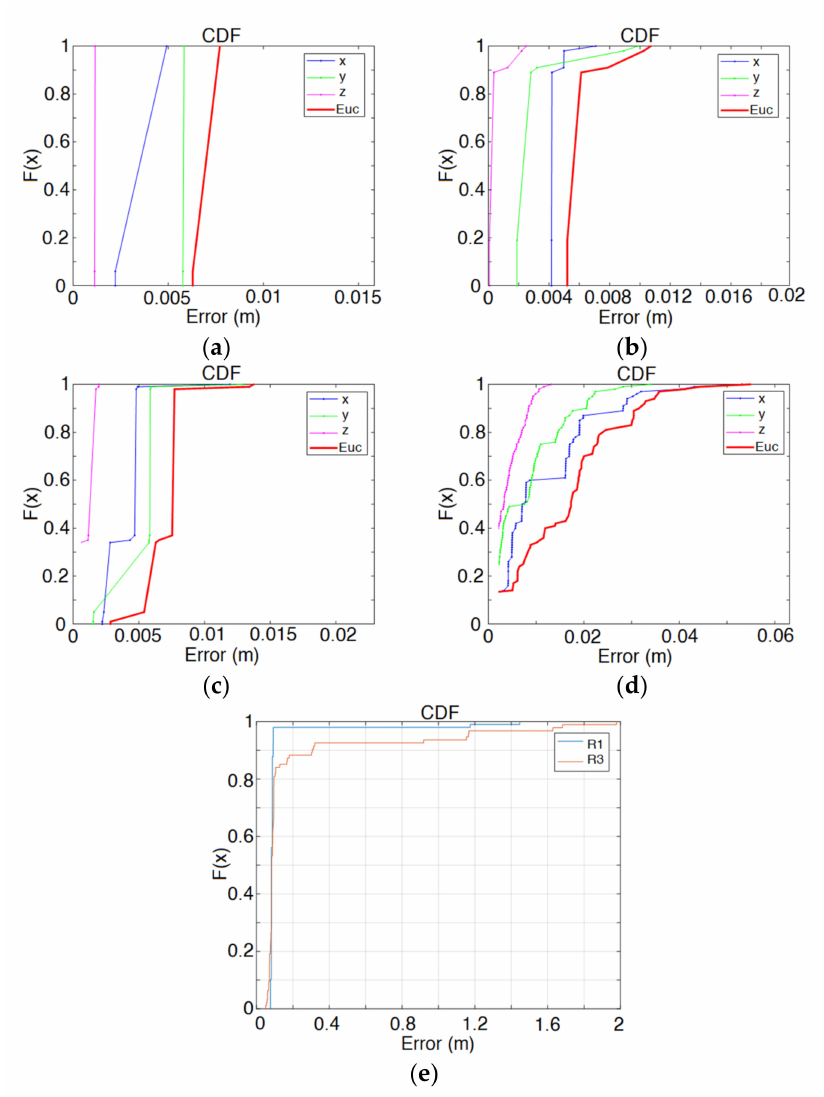
Figure 21. Positioning error CDF: ( a ) simulated results at R1, with SNR = 10 dB; ( b ) simulated results at R3, with SNR = 10 dB; ( c ) simulated results at R1, with SNR = 0 dB; ( d ) simulated results at R3, with SNR = 0 dB; ( e ) experimental